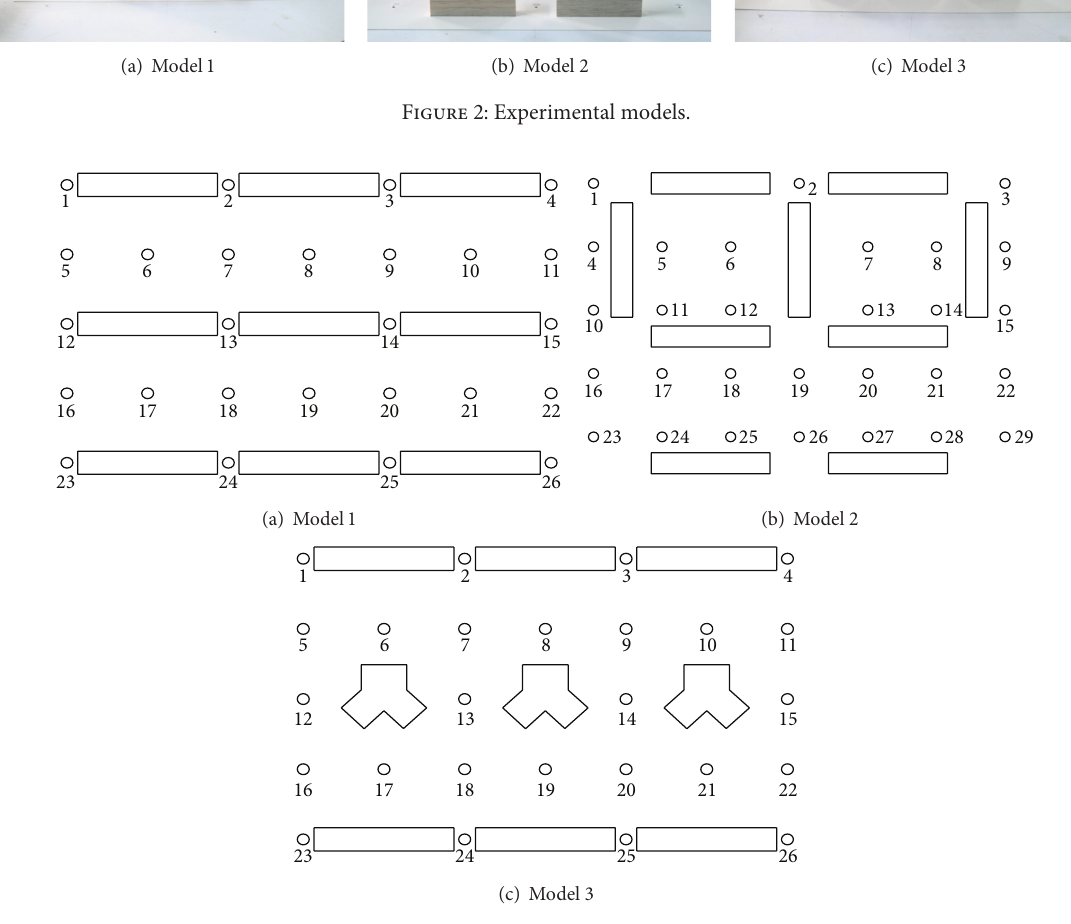
Figure 3: Measuring